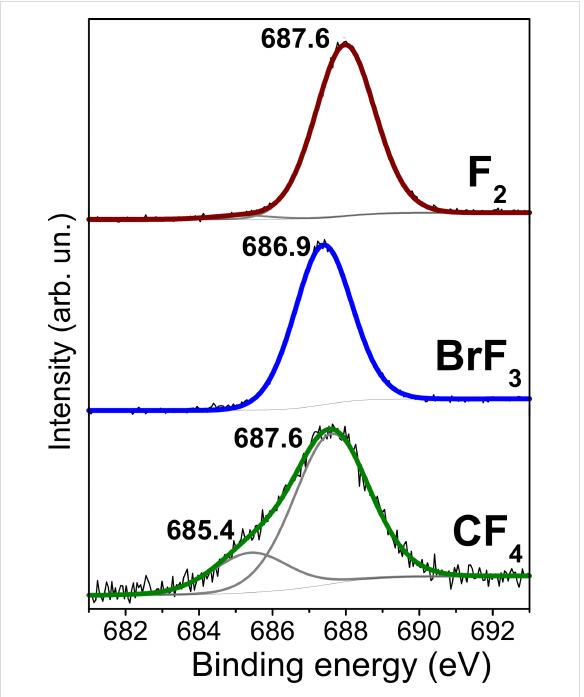
Figure 5: XPS F 1s spectra of DWCNTs fluorinated with CF 4 plasma, BrF 3 , and F 2 .